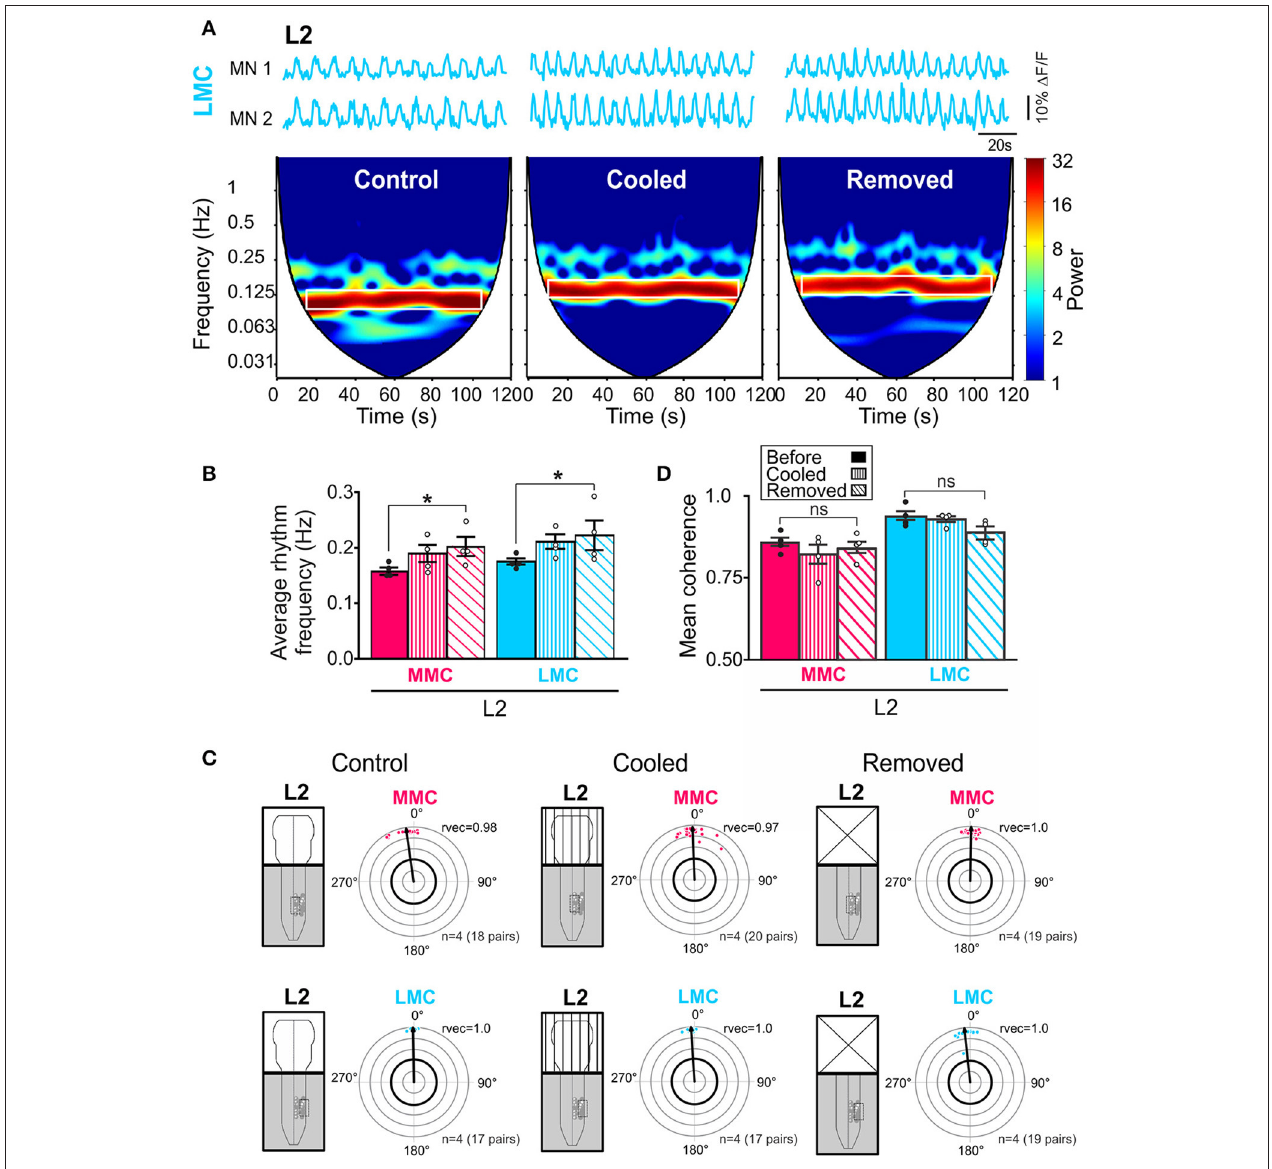
FIGURE 6 | Reduced brain stem activity also increases locomotor rhythm frequency. (A) Three sets of waveforms showing changes in fluorescence in two L2 LMC MNs before and during cooling of the brain stem and after removal of the brain stem. Each set of waveforms is shown with corresponding coherent cross-wavelet transform (CXWT) spectrogram (see Methods). The band of high-power (red) frequencies is marked with a white rectangle indicates a significantly coherence between the two signals in the neighborhood of the locomotor rhythm frequency. The two bottom white regions on either side of the V-shaped “cone of influence” indicate spectra regions not analyzed due to edge effects (Mor and Lev-Tov, 2007). (B) Bar graphs showing the average rhythm frequency in each motor column before (solid bars) and during cooling (vertically hatched bars) of the brain stem, and after removal of the brain stem (obliquely hatched bars). The increase after cooling was not as large as the increase after complete removal of the brain stem but it was observed in all experiments in both MMC and LMC MNs (Friedman test followed by Dunn’s multiple post-hoc comparison, MMC control vs. MMC cooled p = 0.23 MMC control vs. MMC removed p = 0.04; MMC cooled vs. MMC removed p > 0.99; LMC control vs. LMC cooled p = 0.23; LMC control vs. LMC removed p = 0.04; LMC cooled vs. LMC removed p > 0.99). (C) Circular plots showing the effect of cooling and removing the brain stem on the intra-columnar phase differences (Watson–Williams F -test, MMC control vs. MMC cooled F = 0.69, p = 0.46; MMC control vs. MMC removed F = 2.23, p = 0.19; MMC cooled vs. MMC removed F = 0.18, p = 0.68; LMC control vs. LMC cooled F = 2.28, p = 0.18; LMC control vs. LMC removed F = 5.56, p = 0.06 LMC cooled vs. LMC removed F = 1.07, p = 0.34). (D) Bar graphs showing the effect of cooling and removal the brain stem on the intra-columnar coupling strengths (Friedman test followed by a Dunn’s multiple comparison, MMC control vs. MMC cooled p = 0.47; MMC control vs. MMC removed p > 0.99; MMC cooled vs. MMC removed p > 0.99; LMC control vs. LMC cooled p > 0.99; LMC control vs. LMC removed p = 0.23; LMC cooled vs. LMC removed p = 0.47). * p < 0.05.